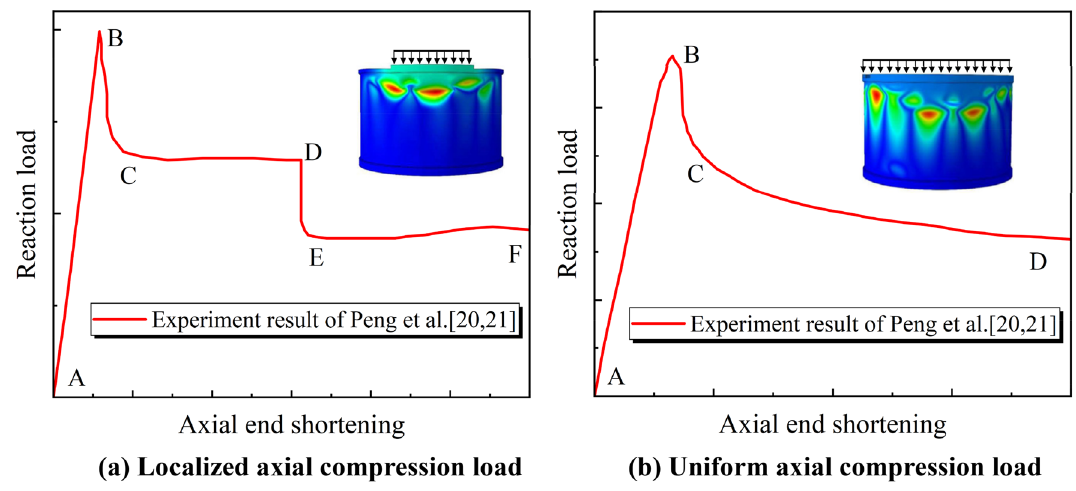
Figure 2. Load–displacement curve of cylindrical shell 19,20